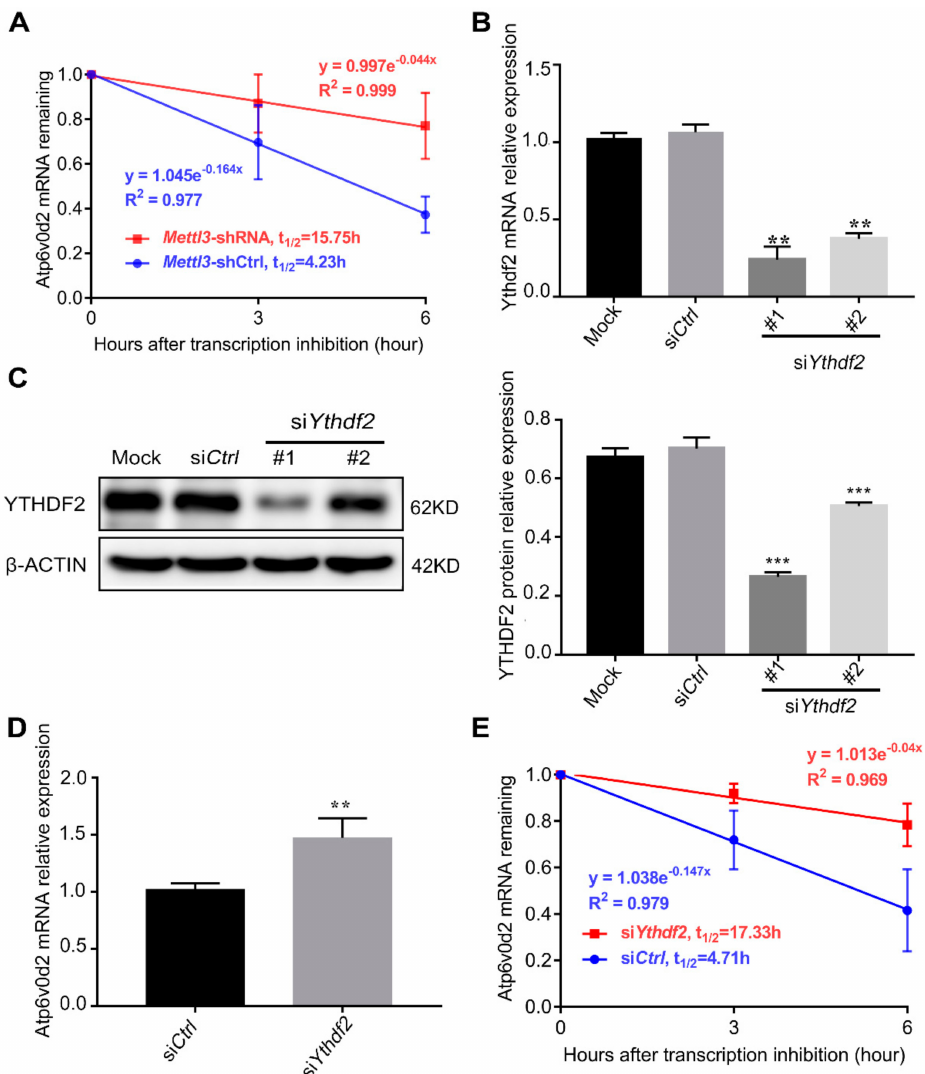
Figure 4. E ff ect of Mettl3 or Ythdf2 knockdown on the mRNA stability of Atp6v0d2. ( A ) RAW 264.7 cells transfected with the negative control shRNA and Mettl3 shRNA were treated with 5 µ g / mL actinomycin D to inhibit global mRNA transcription after stimulation with 50 ng / mL RANKL for 4 days. Atp6v0d2 expression level was measured by qRT-PCR at 0, 3 and 6 h after transcriptional inhibition. ( B , C ) Ythdf2 knockdown in siRNA-transfected RAW264.7 cells was confirmed by both qRT-PCR and Western blotting. Mock, cells transfected with transfection reagent; si Ctrl , cells transfected with negative control siRNA; si Ythdf2 , cells transfected with Ythdf2 siRNA. ( D ) The mRNA expression level of Atp6v0d2 was assessed by qRT-PCR in receptor activator of nuclear factor- κ B ligand (RANKL)-induced RAW264.7 cells transfected with negative control siRNA and Ythdf2 siRNA. (E) The mRNA expression level of Atp6v0d2 in the si Ctrl and si Ythdf2 groups was assessed by qRT-PCR at 0, 3 and 6 h after actinomycin D-mediated transcriptional inhibition. β -Actin was used as a normalization control. The data are presented as the mean ± SD ( n = 3). ** P < 0.01; *** P <